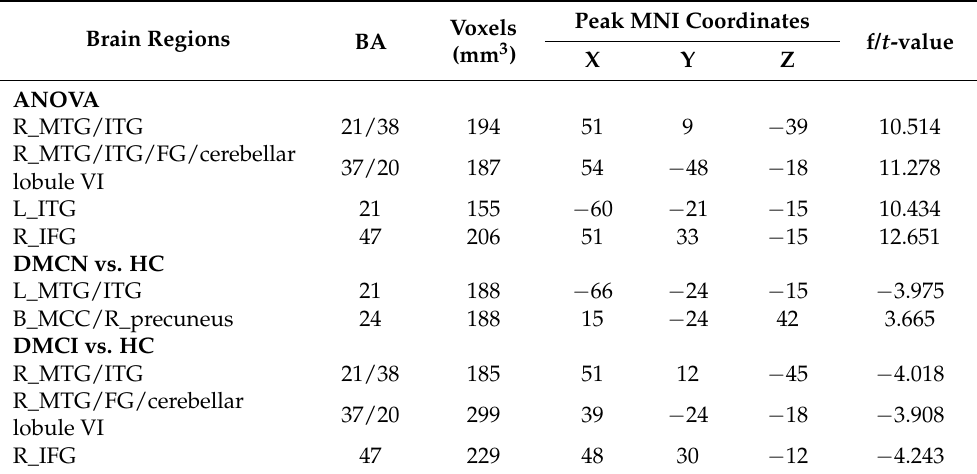
Table 3. Regions of abnormal short-range FCDs among the three groups. Brain